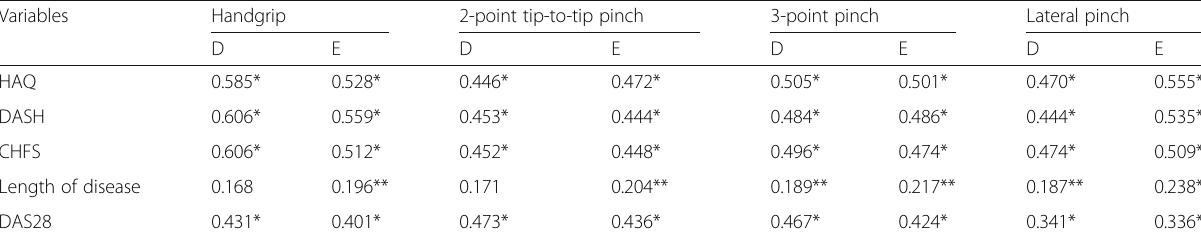
Table 4 Negative correlations among hand strength, functional ability, activity, and duration of disease in the rheumatoid arthritis group (RAG)